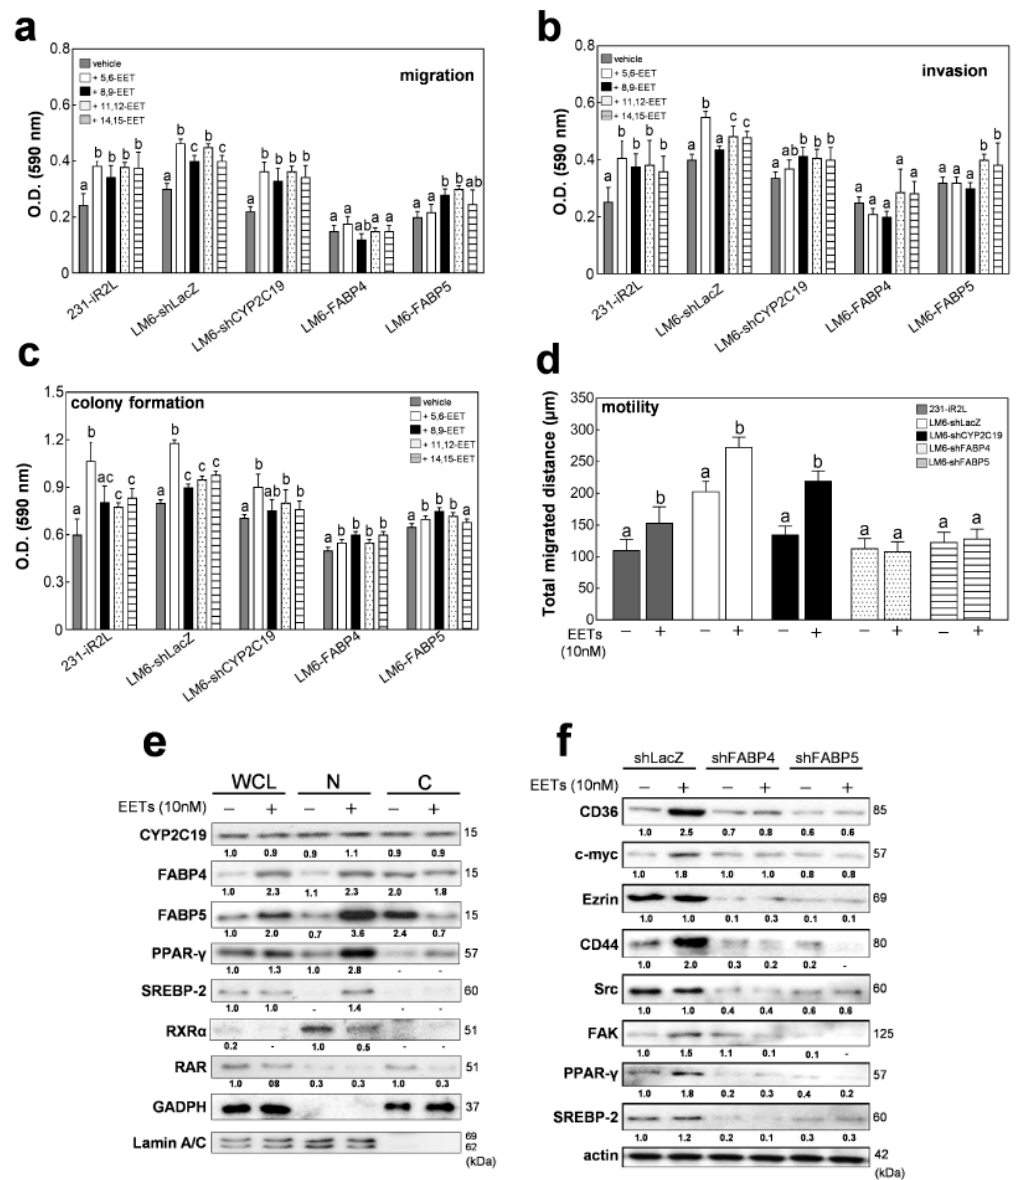
Figure 3. Nuclear translocation of FABP4 and FABP5 drives EET-mediated aggressiveness in lung-seeking metastatic MDA-MB-231 TNBC cells: ( a ) Migration; ( b ) invasion; ( c ) colony formation, and ( d ) motility of each the cell line under study were compared following 24 h culture in media supplemented with 10 nM of a specific EET isomer; ( e ) cellular localization of FABP4 and FABP5, and expression of lipogenic transcription factors PPAR- γ , SREBP-2, RAR, and RXR- α following supplementation of EETs to LM6 cells was determined by Western blotting (WCL, whole cell lysate; N, nuclear fraction; and C, cytosolic fraction); and ( f ) expression of downstream direct targets of PPAR- γ and SREBP-2 in LM6-LacZ, LM6-shFABP4, and LM6-shFABP5 cells grown with or without EET supplementation (10 nM, 2.5 nM each isoform) was determined by Western blotting. All analyses include 3 biological replicates and 4 technical replicates. Error bars indicate mean ± SEM. Statistical significance of the data between different groups are denoted by different letters ( p = 0.05, ANOVA, post hoc Tukey).